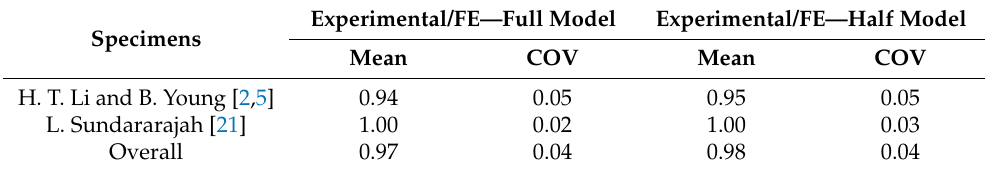
Table 4. Summary of the statistical analysis of